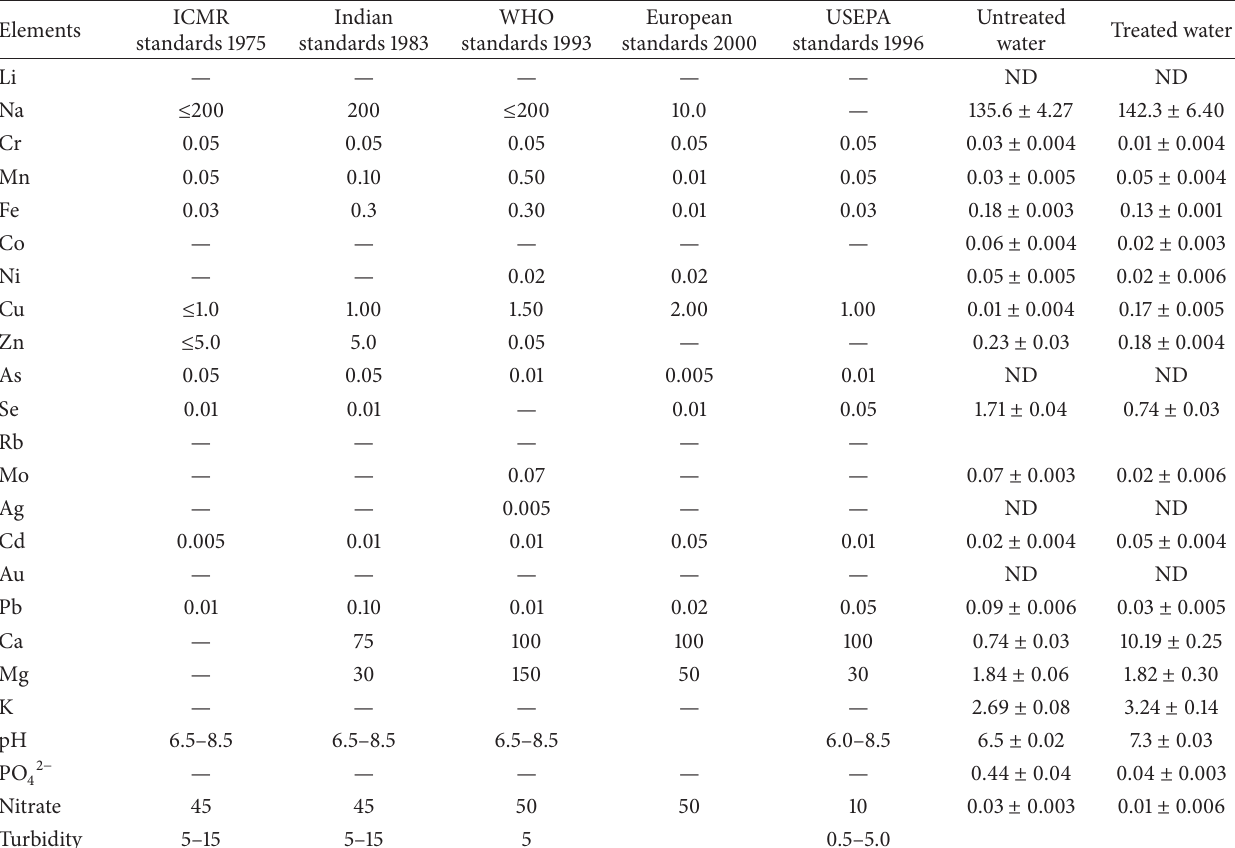
Table 4: Water quality guideline for domestic